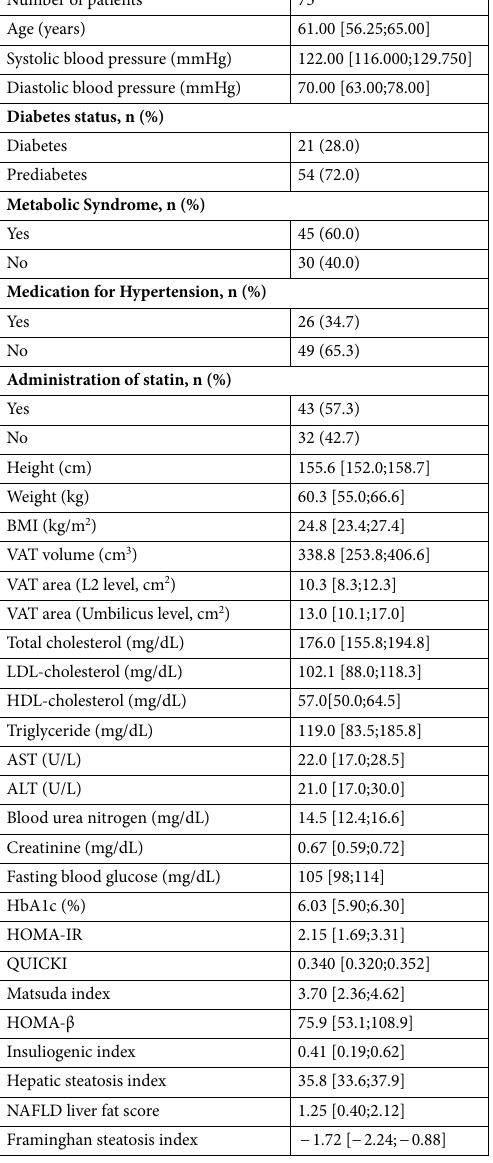
Table 1. Baseline Characteristics. Values are presented as number (%), or median [interquartile range]. BMI, body mass index; VAT, visceral adipose fat tissue; LDL, low-density lipoprotein; HDL, high-density lipoprotein; AST, aspartate aminotransferase; ALT, alanine aminotransferase; ALP, alkaline phosphatase; HbA1c, hemoglobin A1c; HOMA-IR, homeostatic model assessment of insulin resistance, HOMA-β, homeostatic model assessment of β-cell function; QUICKI, quantitative insulin sensitivity check index; NAFLD, nonalcoholic fatty liver